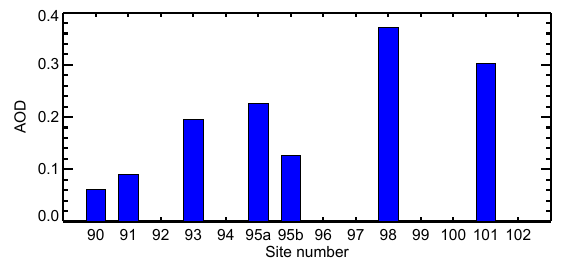
Figure 2. The variation in AOD at 500nm at different sites mea- sured using a Microtops (cid:53) Sunphotometer over northeastern China in January